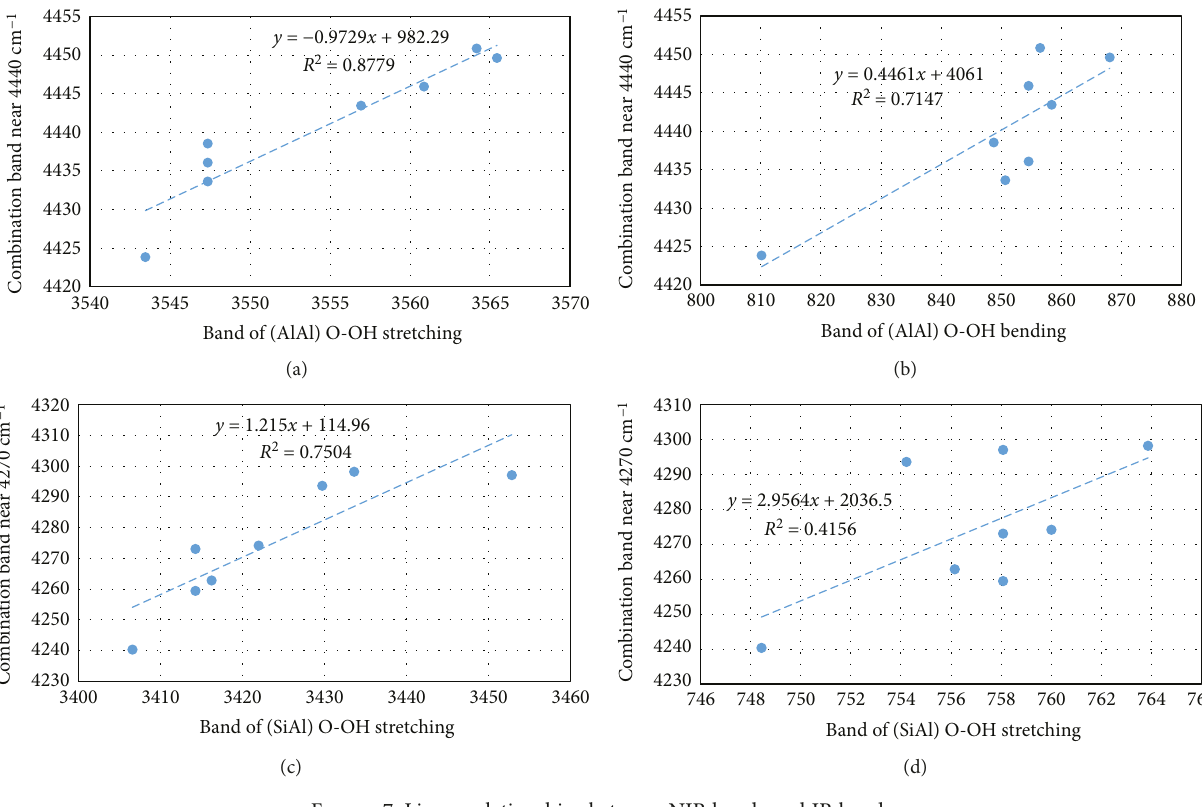
Figure 7: Linear relationships between NIR bands and IR